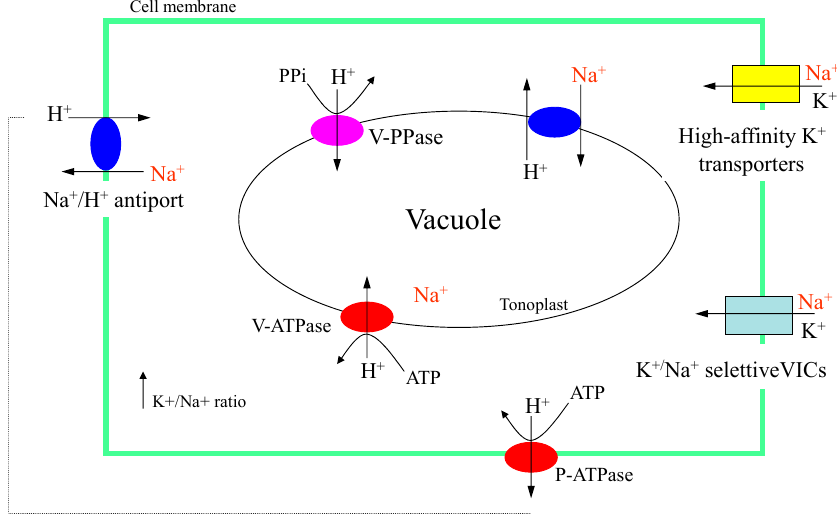
Figure 3. Possible Na + uptake or extrusion in plant cells, including accumulation in the vacuole, for the protection of biochemical processes at the cytoplasm level.